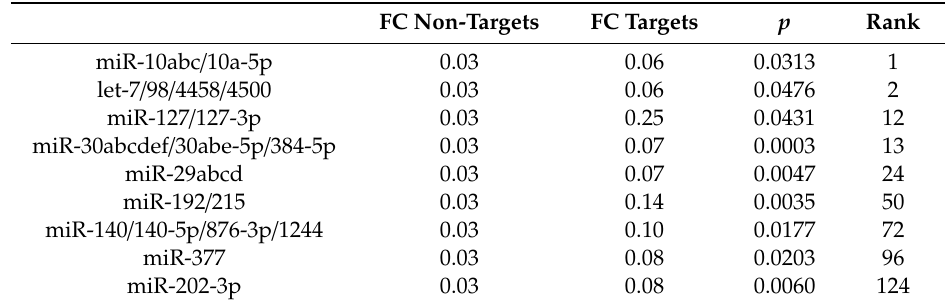
Table 1. List of miRNA families for which targets were significantly modulated by extracellular vesicle (EV) administration in acute kidney injury (AKI)